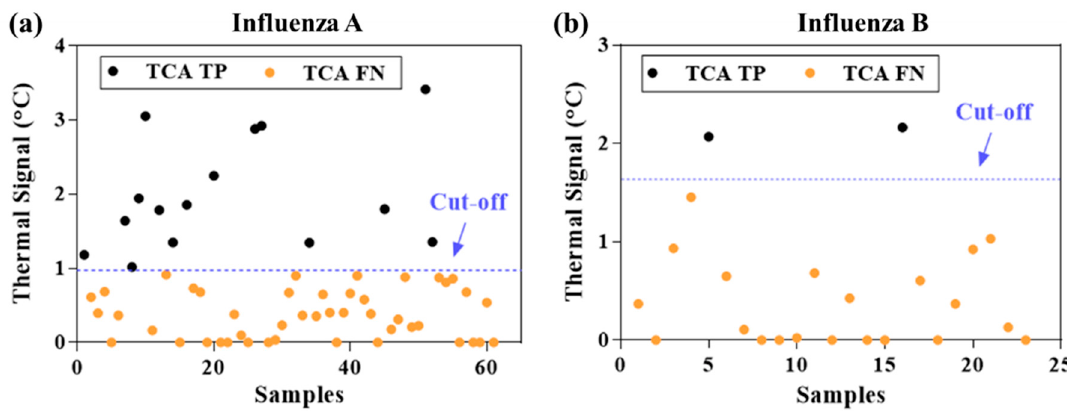
Figure 2. Thermal signals from clinical LFAs that were visually false negatives. ( a ) influenza A: fifteen out of 61 visually false negative samples (~25%) were tested as true positive by TCA. ( b ) influenza B: two out of 23 visually false negative samples (~9%) were tested as true positive by thermal contrast amplification (TCA).